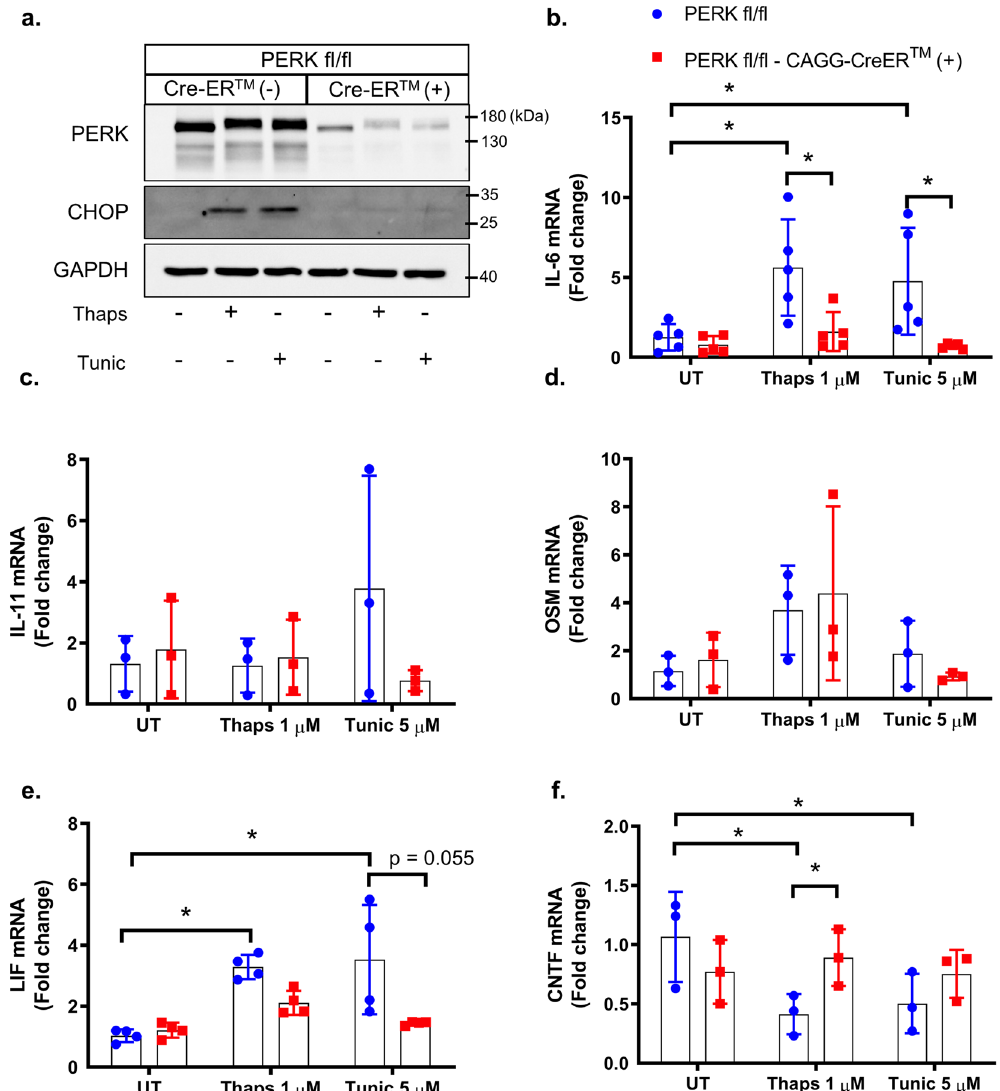
Figure 4. PERK-dependent regulation of the IL-6 family in astrocytes. ( a ) Astrocytes were isolated from PERK fl/fl and PERK fl/fl × CAGG-CreER TM littermates. Primary murine astrocytes were pre-treated with 1 μ M 4-OH- tamoxifen for 48 hours to delete PERK. Subsequently, cells were treated with 1 μ M thaps and 5 μ M tunic for 4 hours followed by immunoblotting to confirm PERK deletion. ( b – f ) Cells were isolated and treated as in ( a ), and mRNA expression was analyzed by qPCR. N = 3–5, * P ≤ 0.05. Full-length blots are presented in Supplementary Fig.